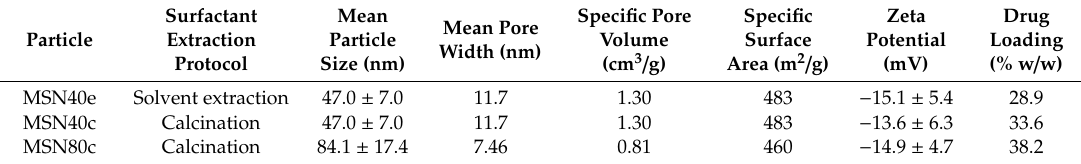
Figure 1. Transmission electron micrographs of ( A ) MSN40c, ( B ) MSN40e and ( C ) MSN80c, where scale bars represent 50 nm. ( D ) Infra-Red Attenuated Total Reflection (IR-ATR) spectra of templating surfactant (CTAB; yellow curve), MSNut (black curve), MSNc (red curve) and MSNe (blue curve), with ( E ) inset of localized region highlighting the presence of OH and CH groups in various MSN. ( F ) Thermogravimetric curves for MSNut (grey curve), MSN40e (black curve), MSN40c (blue curve) and MSN80c (red curve), with ( G ) inset highlighting the degradation within treated MSN. MSN, mesoporous silica nanoparticles. Table 1. Physicochemical properties of MSN.